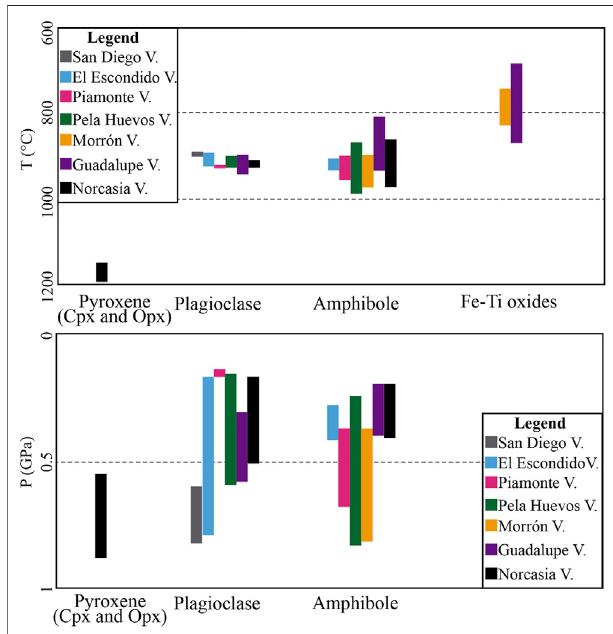
FIGURE 8 | Temperature and pressure ranges of different mineral phases in each volcano as indicated by geothermobarometric results.